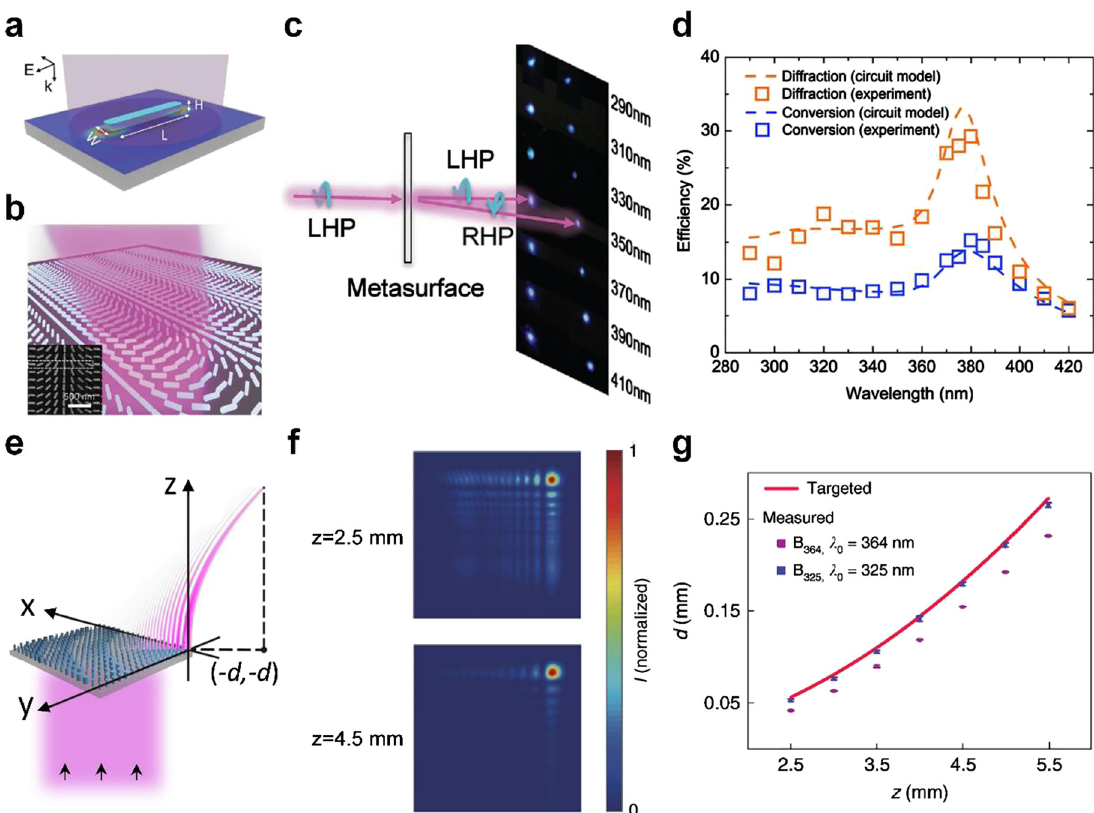
Figure 9: Beam steering by using UV metasurfaces. (a) Sketch for the working principle of Si-based UV geometric metasurfaces. (b) Image of UV metasurfaces for beam steering. (c) Experimental results for steering the UV at the different wavelengths. (d) Measured efficiency of this metasurfaces over a broadband spectrum. Deng et al. [107]. © 2018 WILEY ‐ VCH Verlag GmbH & Co. KGaA, Weinheim. (e and f) Sketch for steering the beam along a curved trajectory (e) via the Airy beam (f). (g) A comparison between the experimental and ideal trajectories at the different z cut planes. Zhang et al. [106]. Author